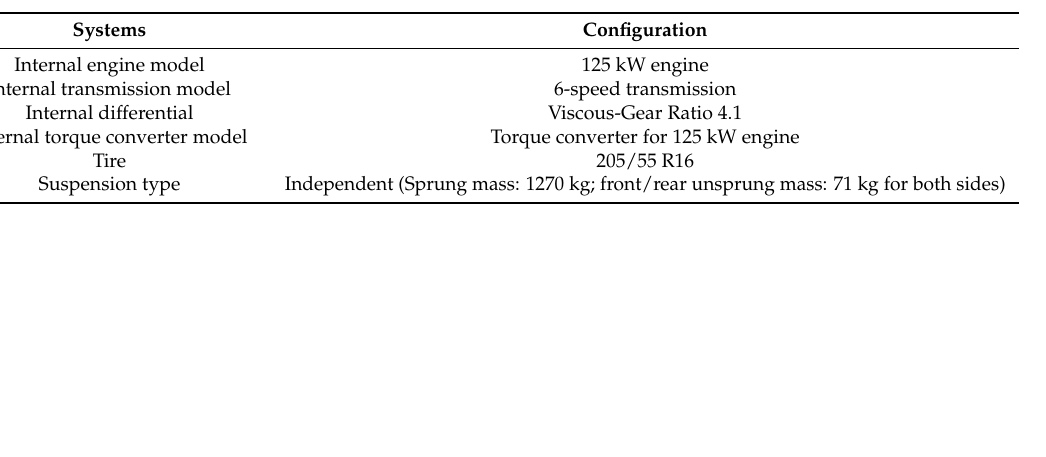
Table 1. Main configuration of a C-class hatchback